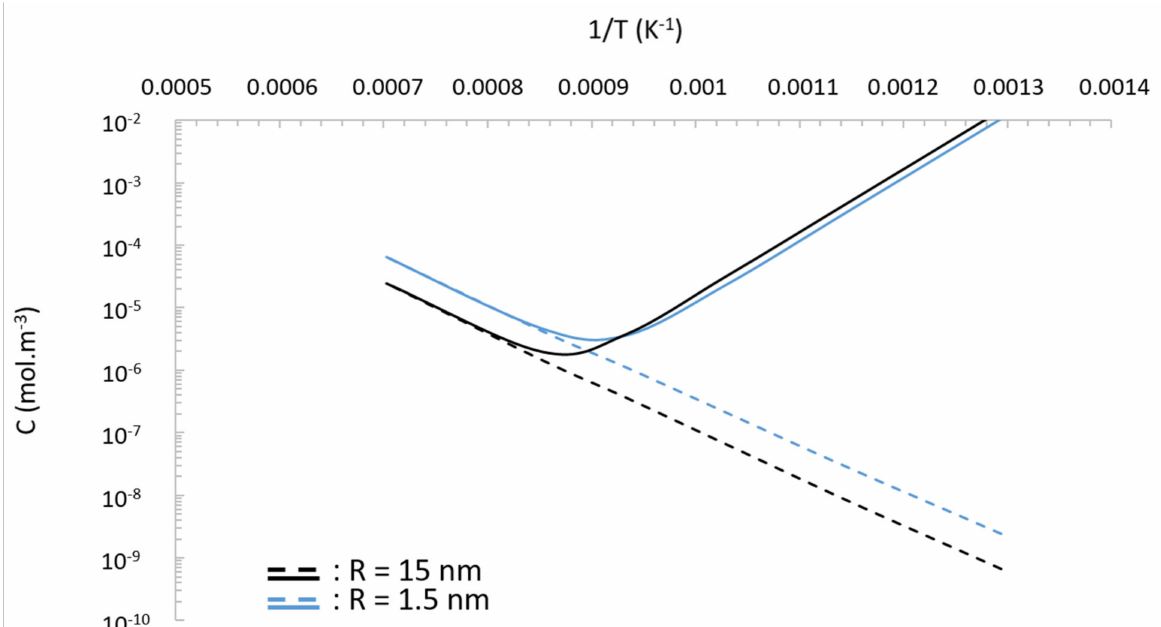
Figure 2. Dependence on the irradiation temperature irradiation of the yttrium solute concentration produced by recoil resolution and by thermal solubility for pyrochlore-type precipitate. Table 2. Values used to calculate the solute concentration according to Equation (4). D 0 is the Y diffusion pre-exponential factor, E m is the diffusion activation energy of Y, C ∞ is the equilibrium solubility of Y in the α -Fe matrix, E s is the equilibrium solubility activation energy of Y, q φ is the irradiation damage rate, λ is the mean displacement of Y ejected atoms, γ is